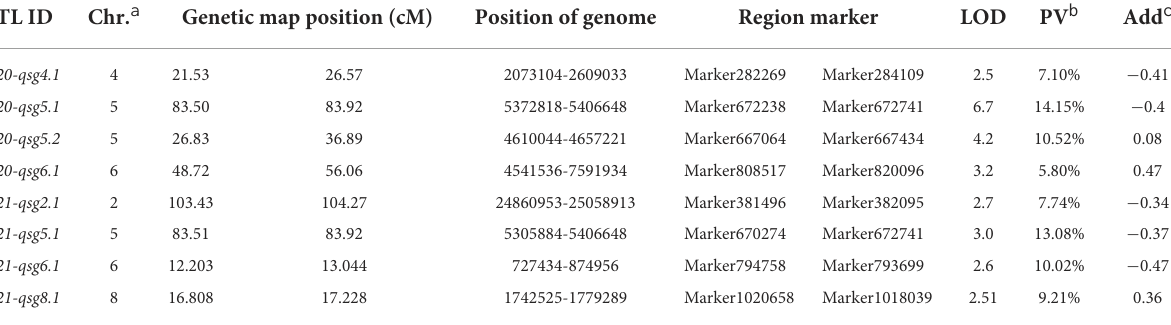
TABLE 4 QTL analysis of seed germination rate using F 2 population obtained by crossing P5 with